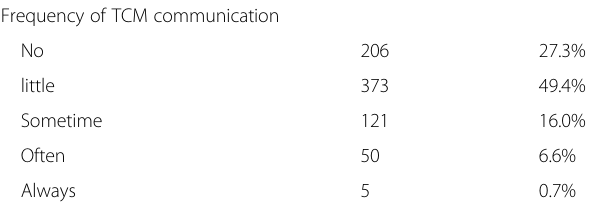
Table 1 Participants ’ demographic characteristics ( n = 755) Demographic characteristics